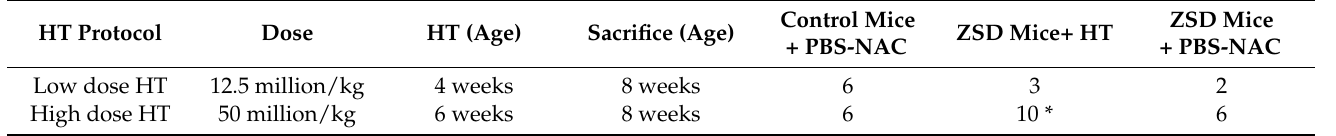
Figure 1. Mouse hepatocyte transplantation (HT) setup and HT protocols description. ( A ) Mouse in right lateral decubitus with intra-splenic 25 G needle insertion. Note the discolored spleen area inside the dotted line confirming the correct intra-splenic infusion flushing erythrocytes. ( B ) Device setup used for HT: syringe press on the right, heating pad (green) and anesthesia tunnel delivering isoflurane mixed with oxygen and collecting exhaled gases. ( C ) Schematic description of the two HT protocols including fasting tests, sacrifices for microchimerism evaluation and samples collection at the end of the study. ( D ) Macroscopic liver evaluation 24 h after high dose HT highlighting large necrosis areas in right and left median lobes. Left lateral lobe displayed smaller necrosis areas (white arrows). Inserts show magnification of the boxed areas. Table 1. Hepatocyte Transplantation Protocol Description.